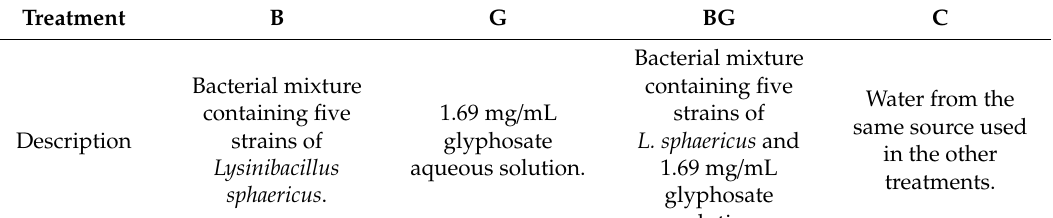
Table 1. Description of each treatment.